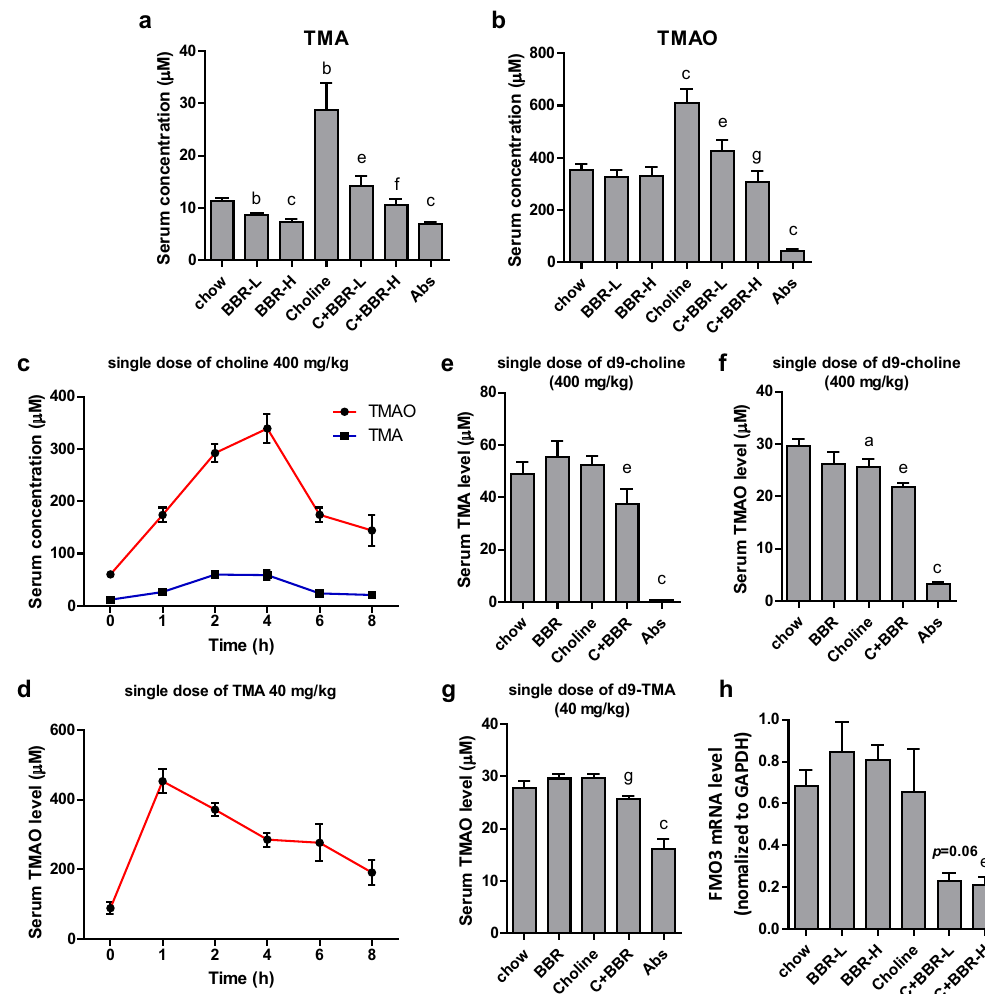
Fig. 2 BBR decreased TMAO level in ApoE KO mice. a , b Eight-week-old female ApoE KO mice ( n = 10 per group) were fed a chow or choline (1%) diet with or without BBR (BBR-L, 100 mg/kg; BBR-H, 200 mg/kg) and chow with Abs for 4 months. Serum TMA and TMAO levels were measured by HPLC/MS. c , d Eight-week-old female C57BL/6J mice were administered a single dose of choline (400 mg/kg, n = 10) or TMA (40 mg/kg, n = 10). Blood samples were collected at indicated times and serum TMA and TMAO levels were determined by HPLC/MS. e – g ApoE KO mice fed a chow diet or choline diet (1%) with or without BBR (100 mg/kg) for 4 months ( n = 10 per group) were administered a single dose of d9-choline (400 mg/kg) or d9-TMA (40 mg/kg). At 4 h after choline was given, or 1 h after TMA was given, the mice were euthanized and blood was collected. Serum d9-TMA and d9-TMAO levels were determined by HPLC/MS. h Expression levels of FMO3 gene mRNAs were quanti fi ed using RT-qPCR assays. Values are presented as means ± SEM ( n = 10). a p < 0.05; b p < 0.01; c p < 0.001 (versus chow- diet group); e p < 0.05; f p < 0.01; g p < 0.001 (versus choline-diet grou p